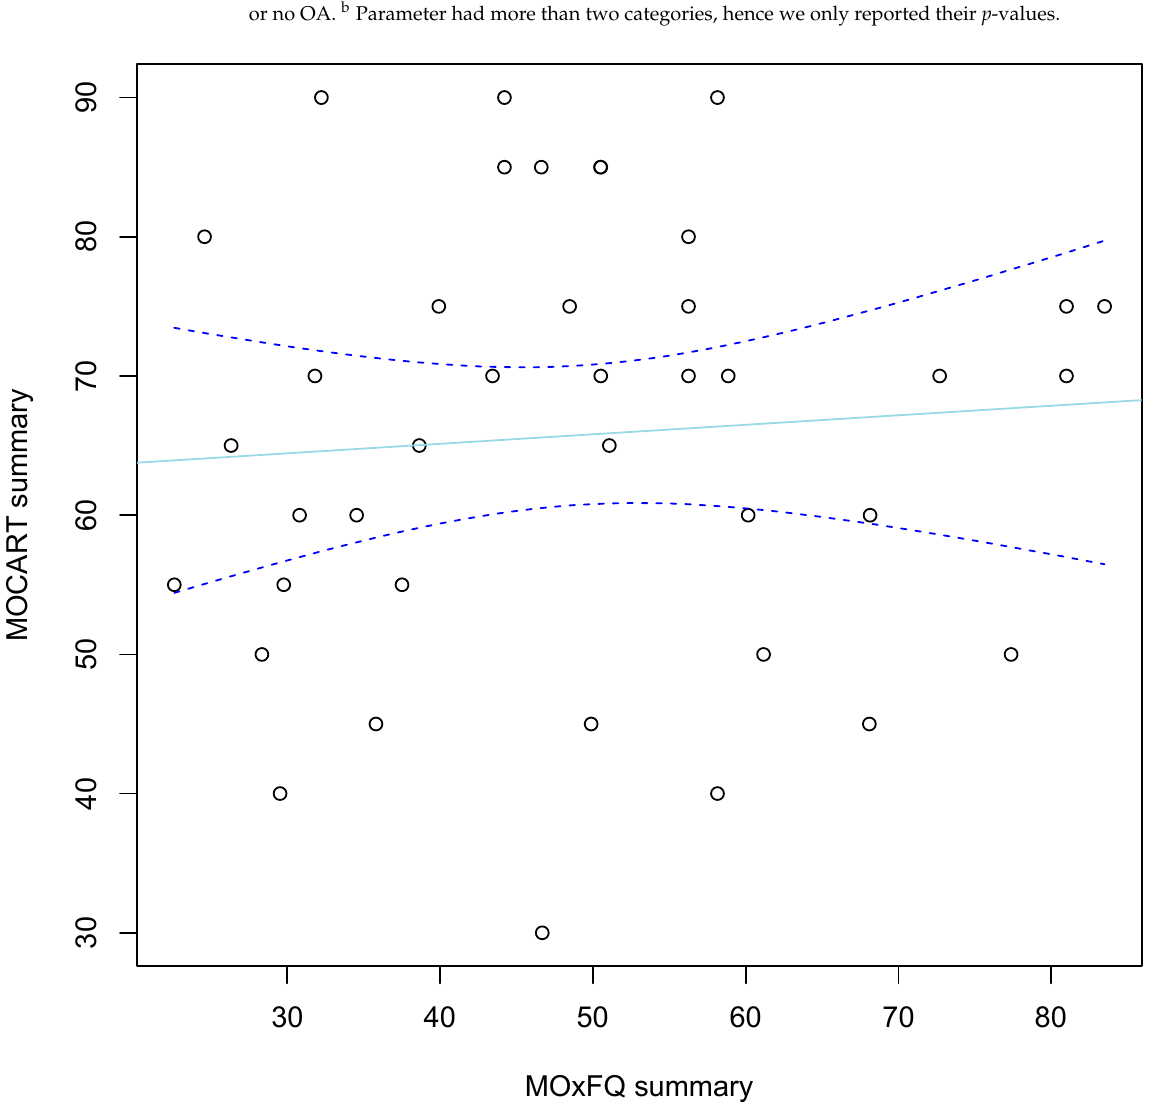
Figure 3. Plot of MOCART scores vs concurrent MOXFQ summary index scores. No evidence was found of a correlation (r = − 0.25, 95%CI − 0.62 to 0.20). Best-fit line: solid light-blue, 95% CIs: dashed dark-blue lines.